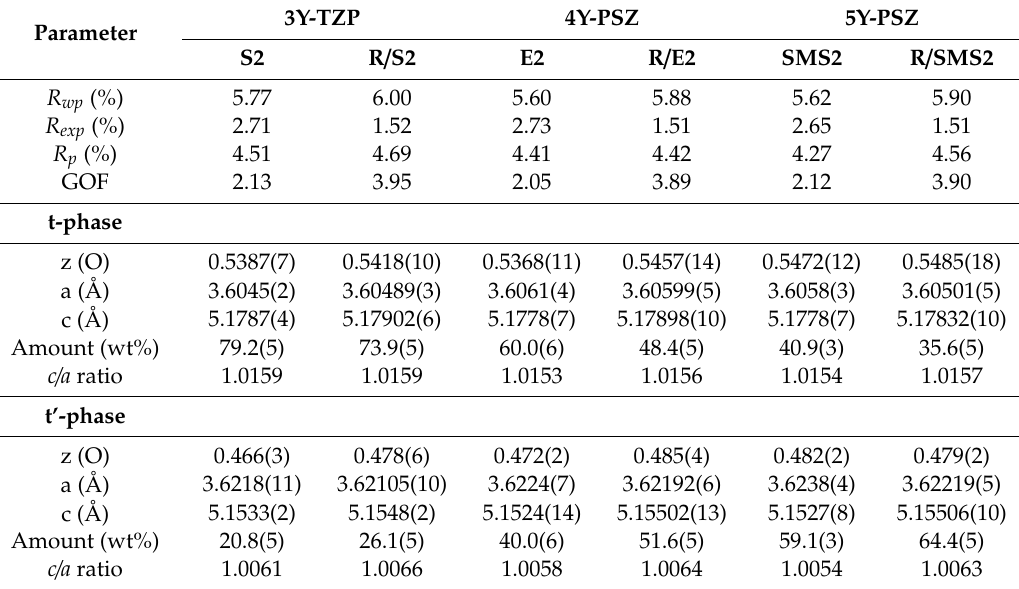
Table 4. Phase compositions and lattice parameters obtained by Rietveld analysis.